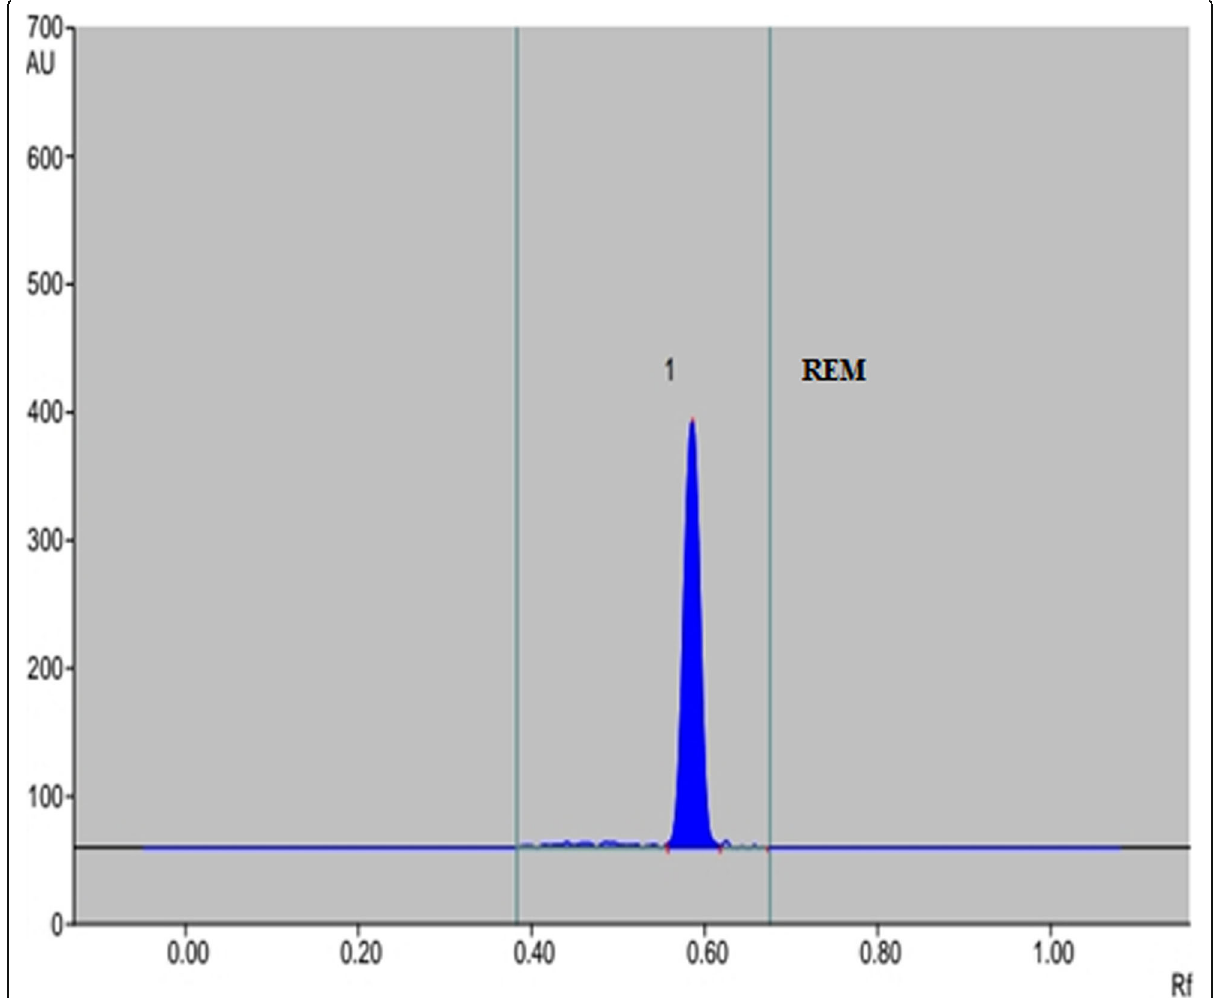
Fig. 3 Densitogram of REM in optimized mobile